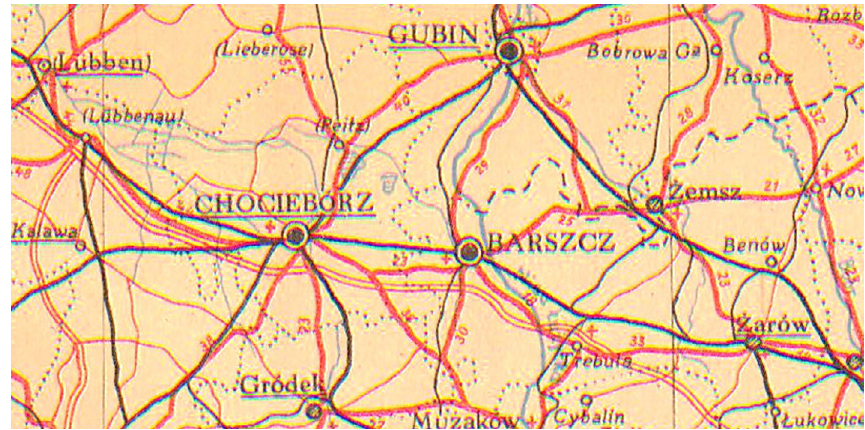
Fig. 5. Part of Polska Zachodnia. Mapa komunikacyjno-administracyjna , 1:1,000,000, 1945